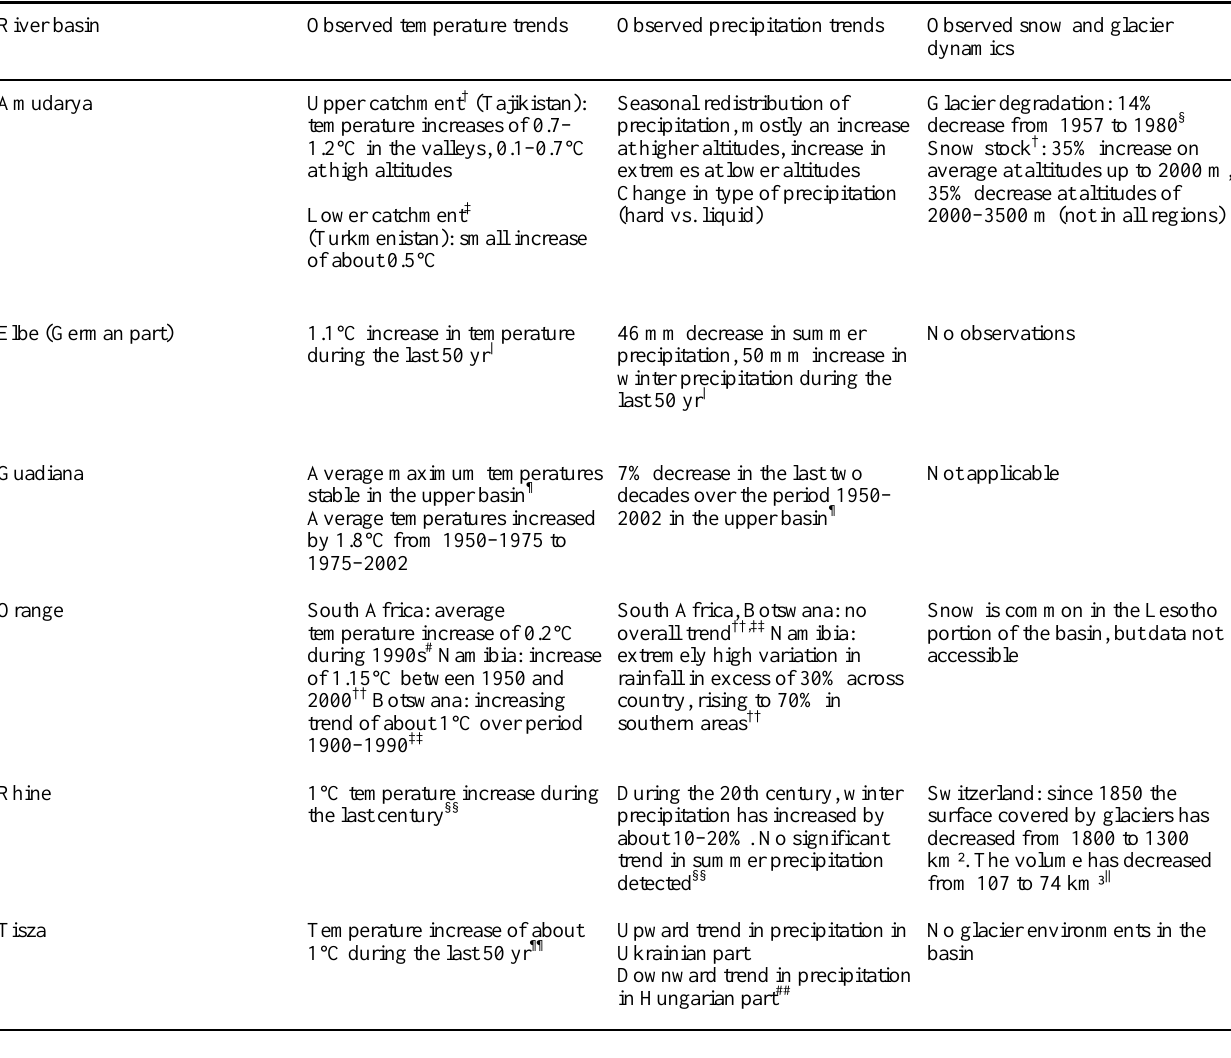
Table 5. Observed trends in climate and projected climate scenarios for six of the seven basins studied. The Nile, which runs through 10 countries, was not included because of insufficient data. Table 5A. Indicators of climate change trends.